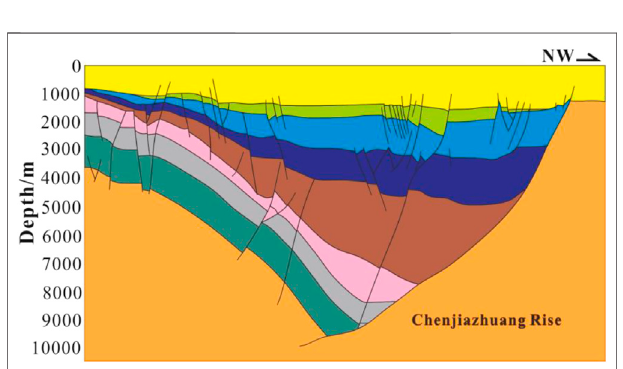
FIGURE 2 | Present day north to south structural section of Dongying Depression (modi fi ed after Song et al., 2014).